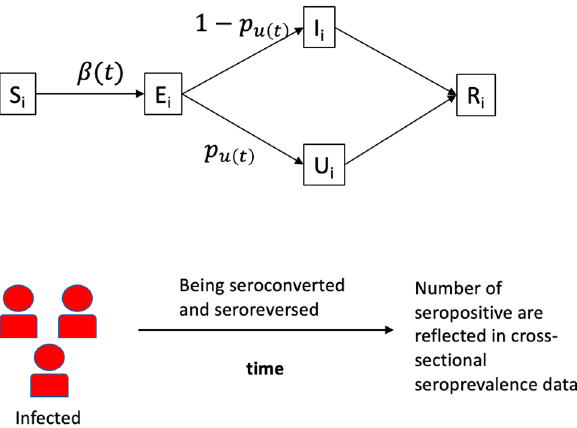
Figure 5. A schematic illustration of our modelling